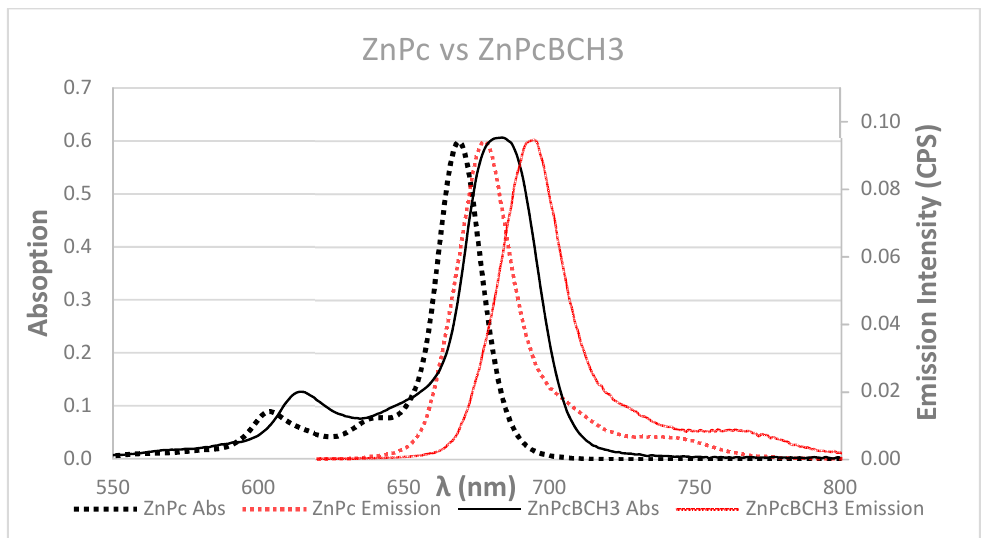
Figure 4. Absorption and emission spectra of ZnPc and ZnPcBCH 3 in DMSO. Table 1. Photophysical properties of ZnPc and ZnPcBCH 3 in DMSO obtained in plate reader with correction factor of 0.32.